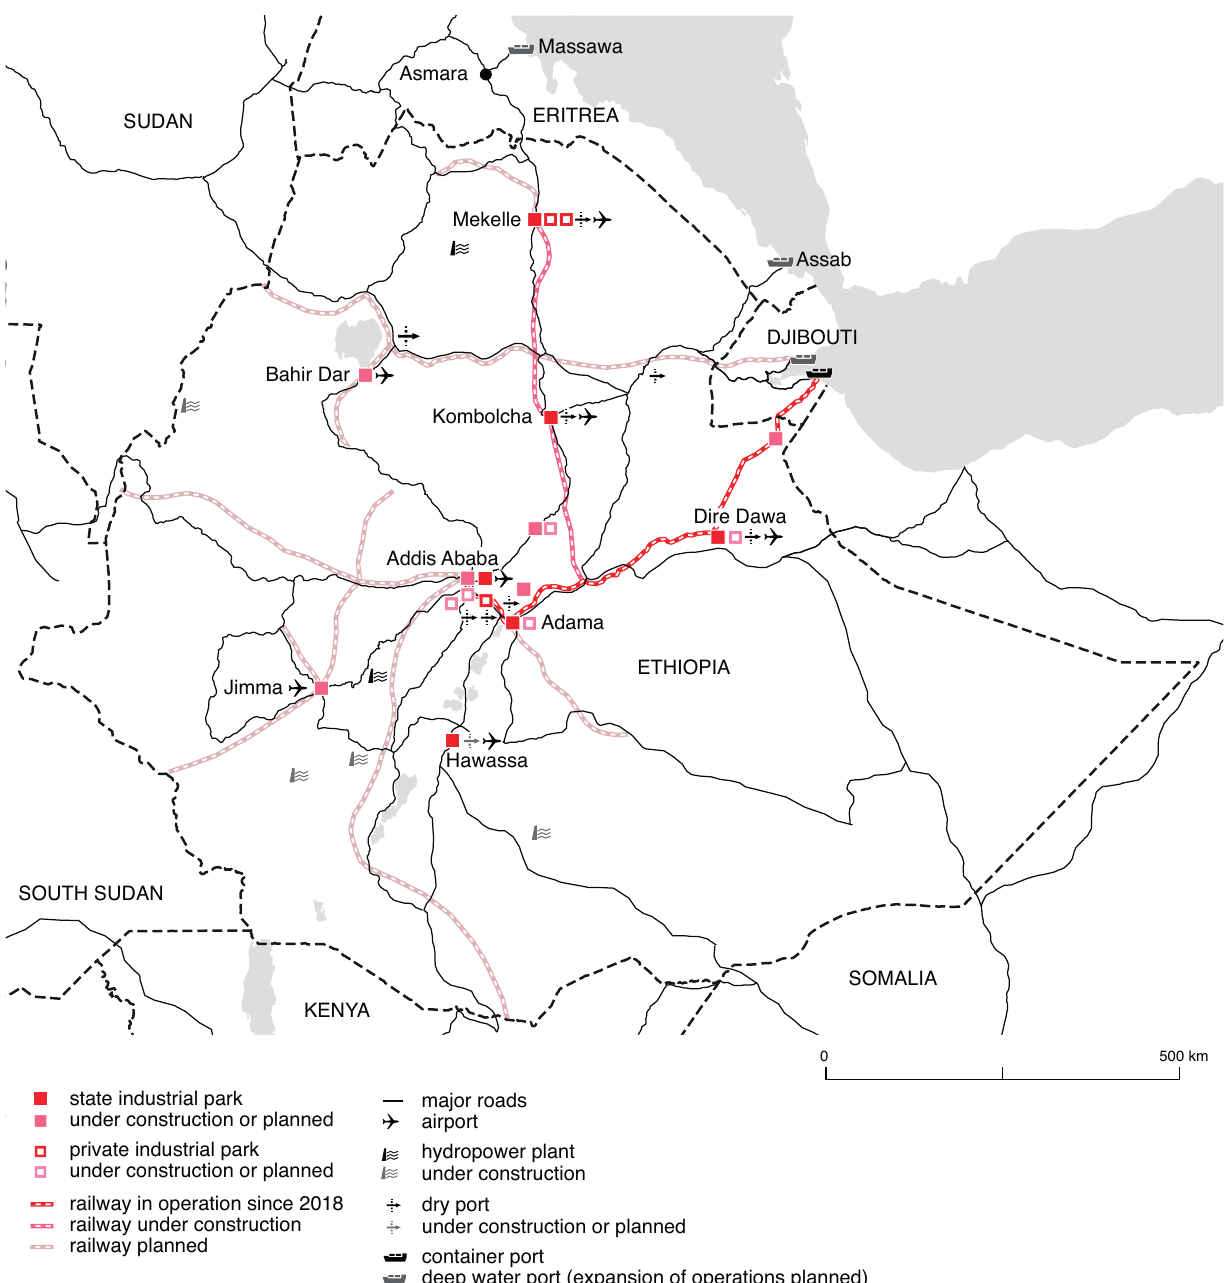
Figure 5. Industrial park and infrastructure development in Ethiopia (2018). Sources: Authors based on Google Maps, OpenStreetMap, Map Library, Ethiopian Investment Commission (2017), IPDC (2015), Embassy of Ethiopia in Brussels (2016), and authors’